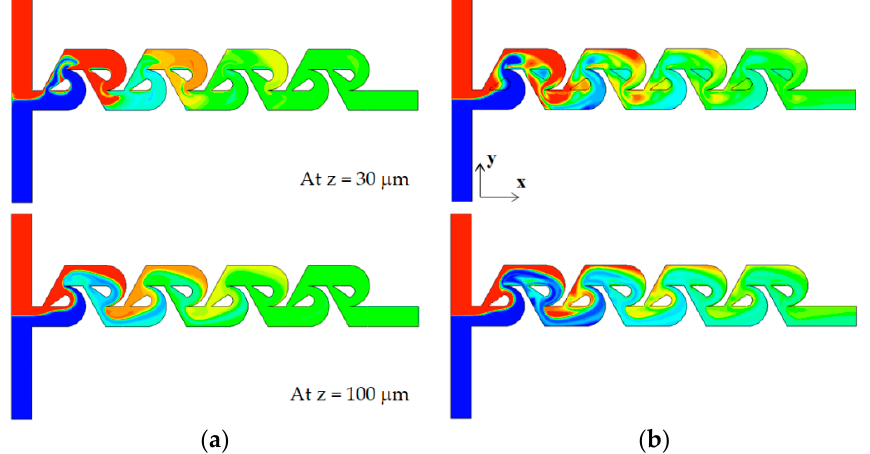
Figure 16. Comparison of concentration contours on the xy planes for Re = 50: ( a ) no clearance and ( b ) with tip clearance h = 60 μ m.